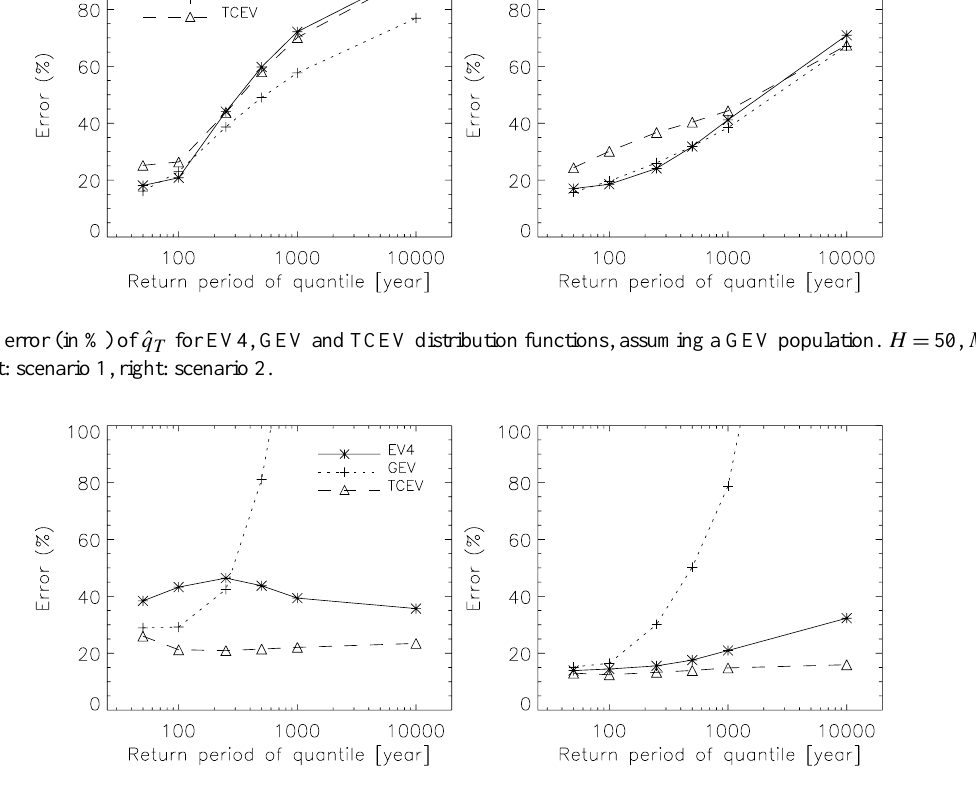
Fig. 8. Estimation error (in %) of ˆ q T for EV4, GEV and TCEV distribution functions, assuming a TCEV population. H = 50, M = 400 and N = 50 years. Left: scenario 1, right: scenario